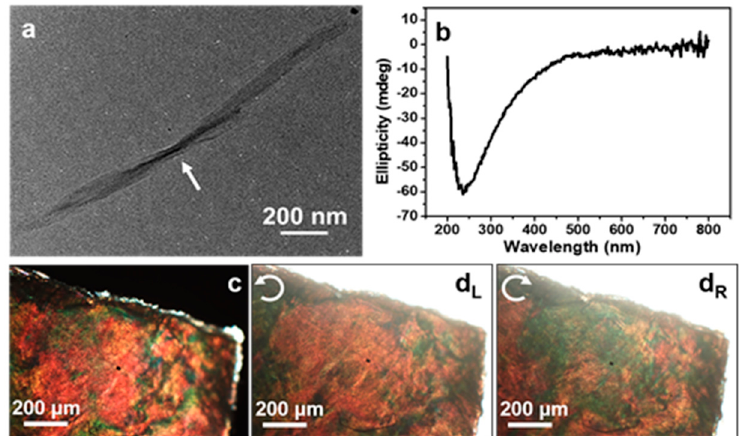
Figure 3. ( a ) TEM image of CNC derived from bacterial cellulose. ( b ) CD spectrum of 3 wt % aqueous solution of the bacterial cellulose-derived CNC. ( c ) Polarizing optical microscope (POM) image of BC (thickness = 55 μ m) under crossed polarizers. Transmitted optical images of BC-paper (thickness = 55 μ m) by 400–700 nm circularly polarized light: ( d L ) left and ( d R ) right.